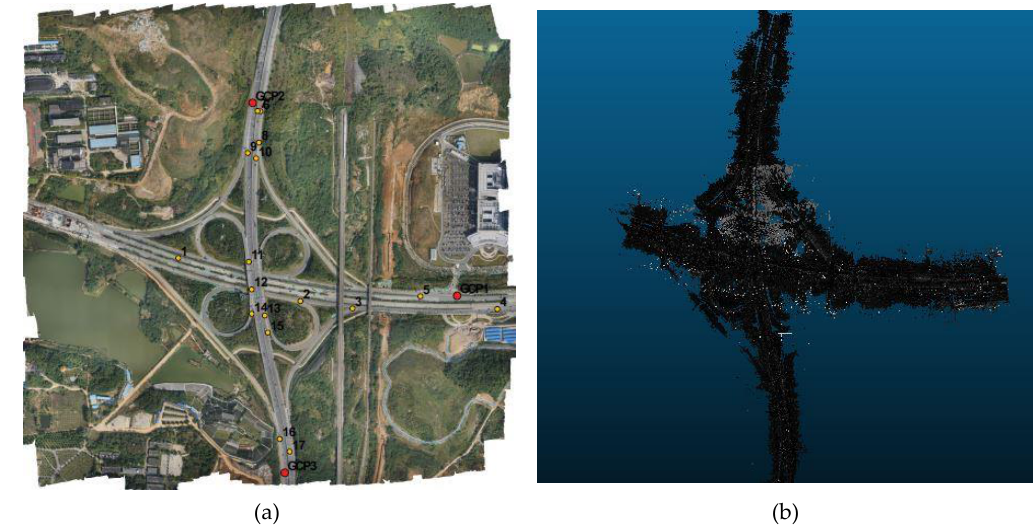
Figure 6. Detail of study area: ( a ) Orthophoto image; ( b ) vehicle-borne LiDAR Data.